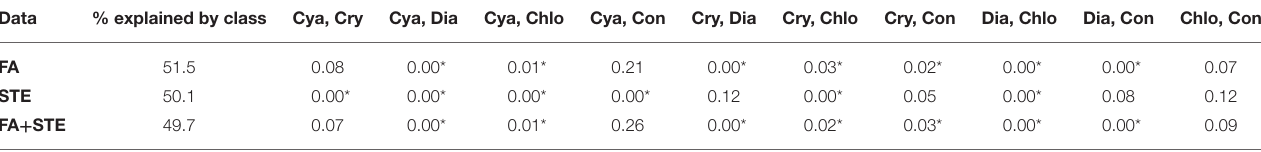
TABLE 4 | Monte Carlo p -values from the pair-wise comparisons (PERMANOVA) of fatty acid (FA), sterol (STE), fatty acid and sterol (FA + STE) composition. Data % explained by class Cya, Cry